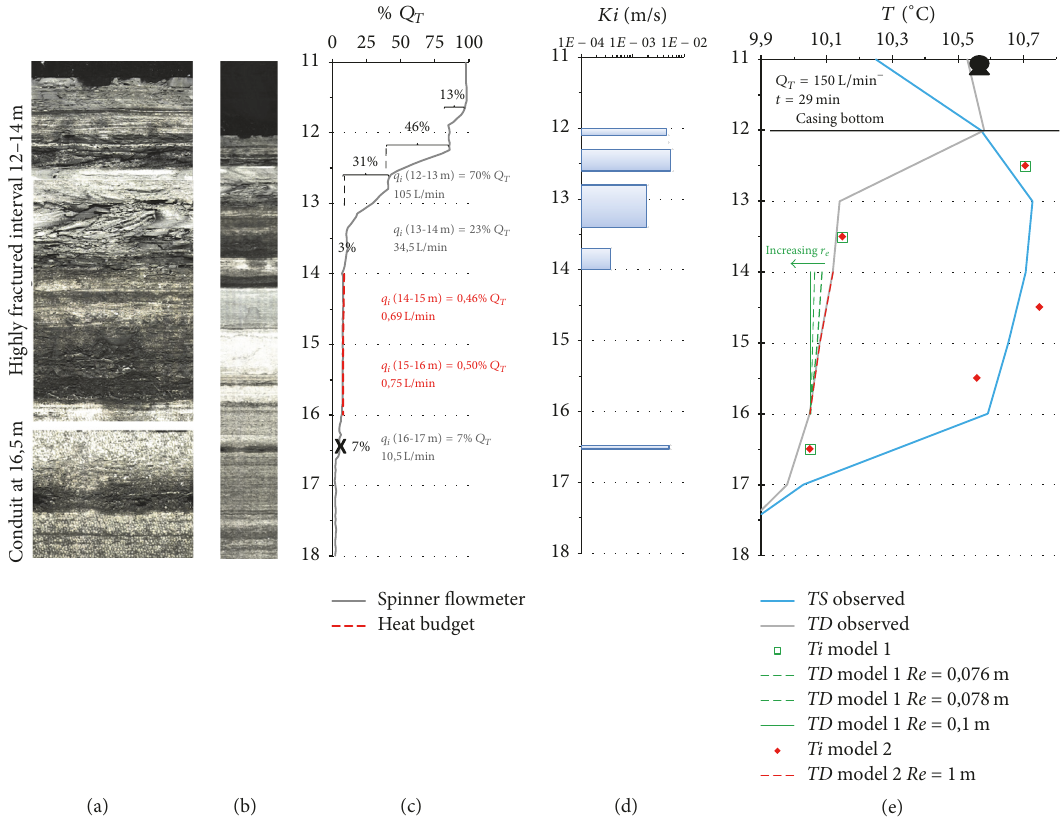
Figure 11: Borehole F3 logging results: (a) televiewing close-up of productive intervals, (b) televiewing log, (c) flow distribution obtained by flowmeter and flow calculated with the heat budget between 14 and 16m depth, (d) vertical distribution of hydraulic conductivities obtained by flowmeter, and (e) temperature profiles under static and dynamic conditions and temperature of groundwater inflows calculated with the heat